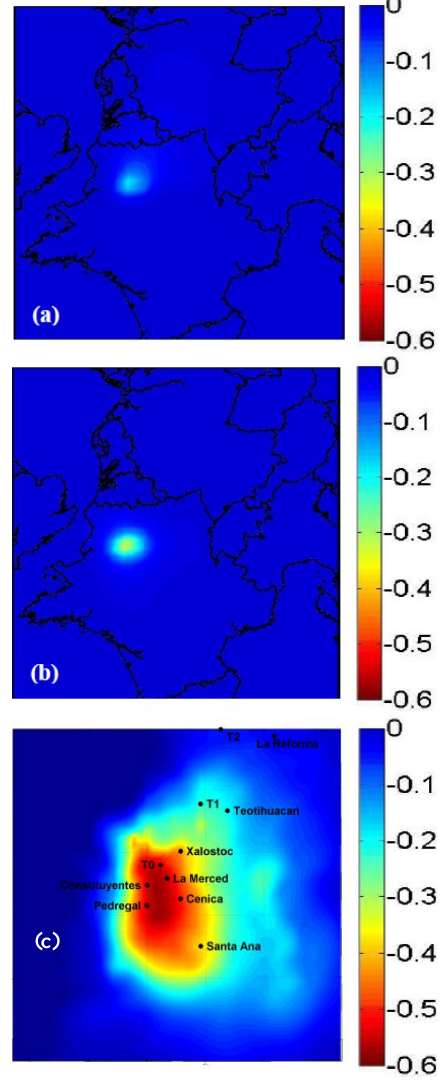
Figure 5. Predicted relative decrease in PM 2 . 5 levels when lo- cal emissions of the megacity are set to zero; calculated with the PMCAMx model for the summer (a) and winter (b) MEGAPOLI campaigns for the greater Paris region, and during the MILAGRO (Megacity Initiative: Local And Global Research Observations) campaign (c) for Mexico City. Domain widths: 5400 × 5832km 2 plus a subdomain of 216 × 180km 2 for Paris, 210 × 210km 2 for Mexico